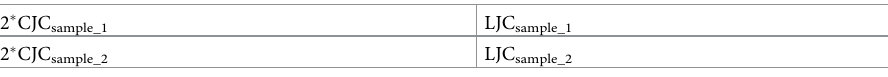
Table 1. 2x2 table used for Fisher’s exact